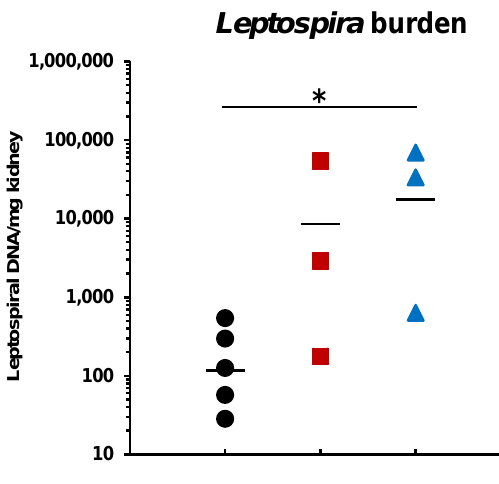
Figure 4. Leptospiral burden in the kidneys of surviving hamsters after challenge. The leptospiral genome was detected by qPCR. The cycle threshold of each sample was compared with leptospiral DNA standard curve to calculate bacterial load, which is expressed as bacterial DNA per milligram of tissue. Mann–Whitney U test was used to compare bacterial number among vaccination groups; * represents p < 0.05.